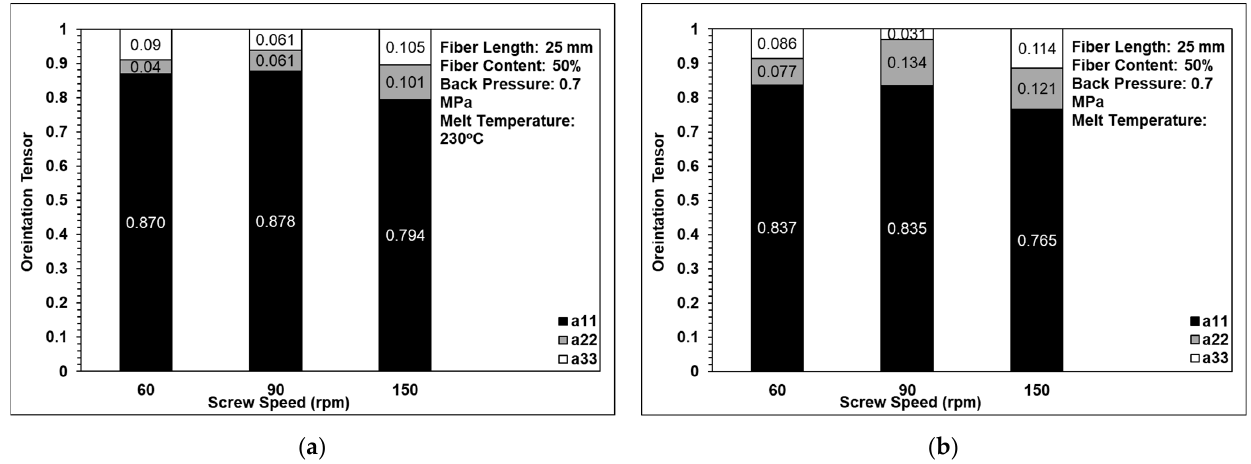
Figure 12. Effects of screw speed on fiber orientation in ( a ) the single-edge gate and ( b ) the single- sprue gate.